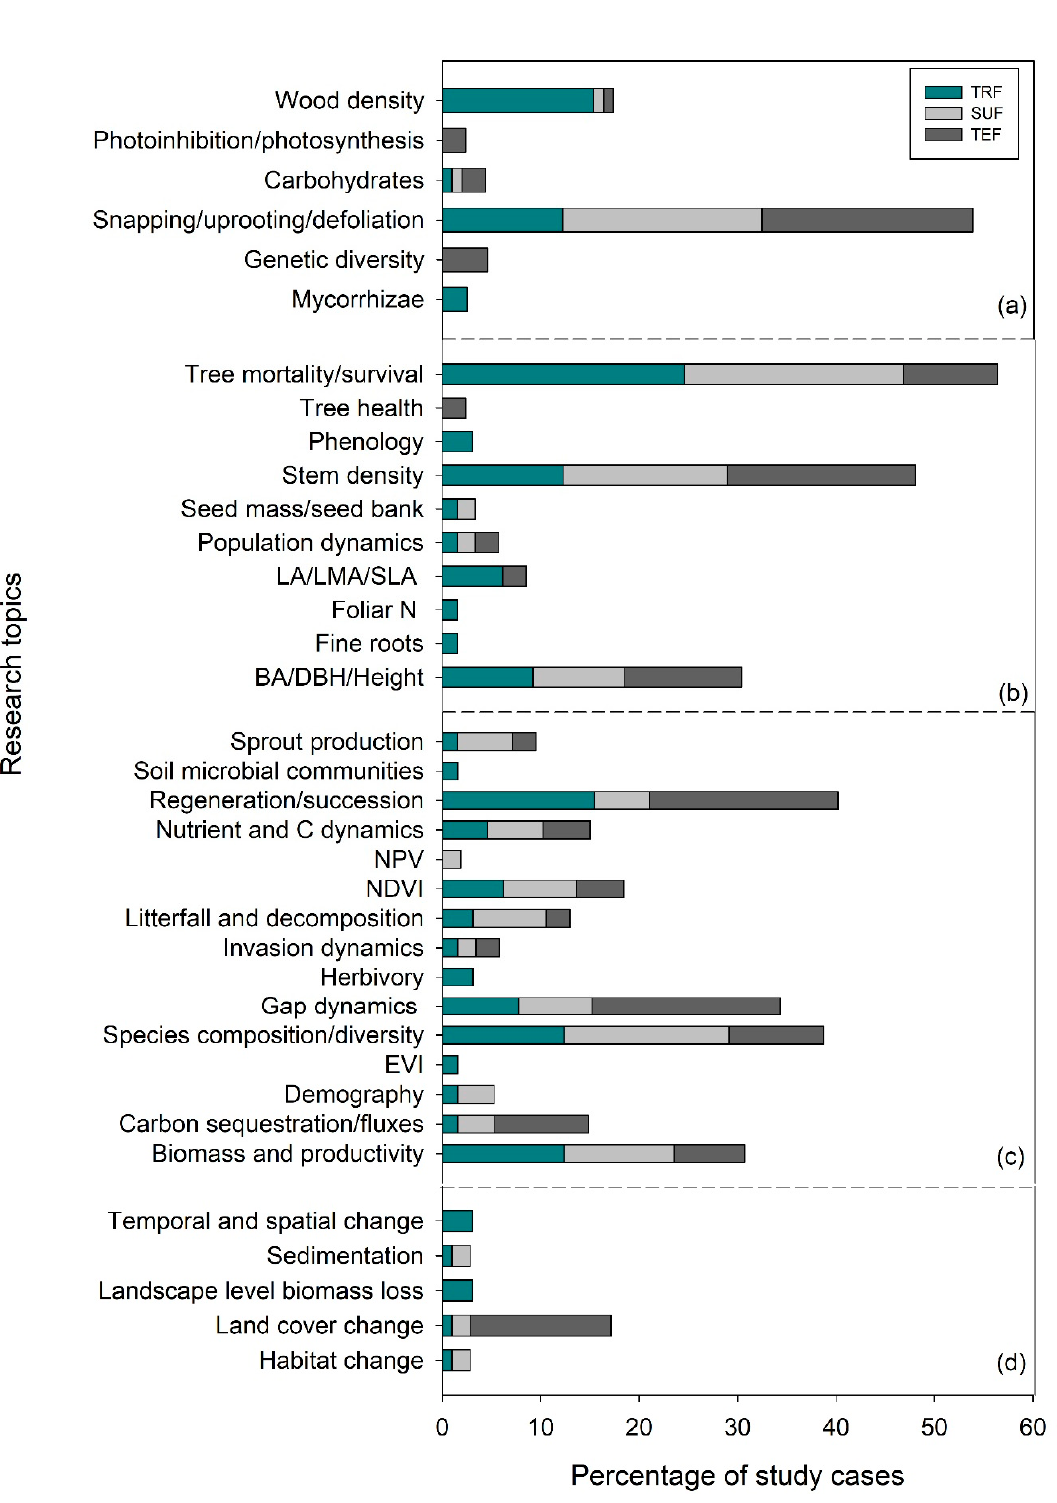
Figure 1. Percentage of study cases by research topics at ( a ) molecular-cellular-individual, ( b ) species- population, ( c ) community-ecosystem, and ( d ) landscape levels. Abbreviations: TRF—tropical forest, SUF—subtropical forest, TEF—temperate forest; LA—leaf area, LMA—leaf mas per unit area, SLA— specific leaf area, N—nitrogen, BA—basal area, DBH—diameter at breast height, NPV— Enhanced Vegetation Index. Percentages were computed based on the total number of articles that belong to each main and subcategory.